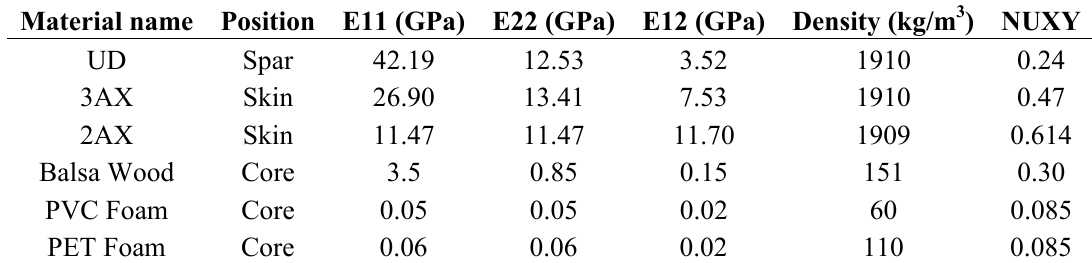
Table 2. Material properties for composite blade.